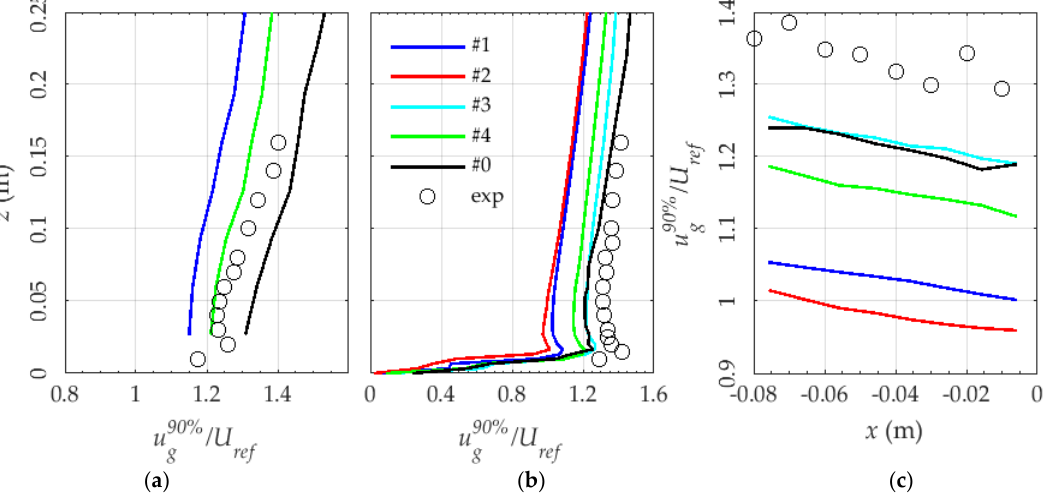
Figure 14. 90th quantile of the wind speed at the rooftop of the Muirhead tower ( a ) and Biosciences building ( b , c ).